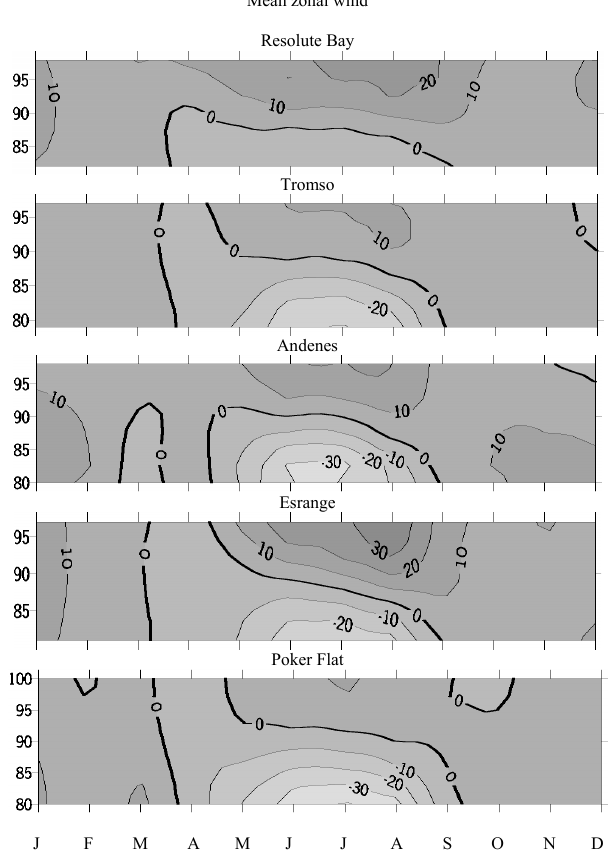
Fig. 4. Monthly mean zonal wind (m/s) measured at Arctic stations. Left axis is height (km), horizontal axis shows month of